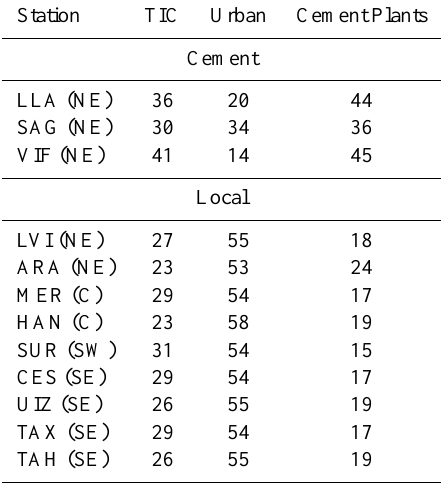
Table 2. WRF-Chem results of stations with highest contribution from urban sources and cement plants. All quantities are in